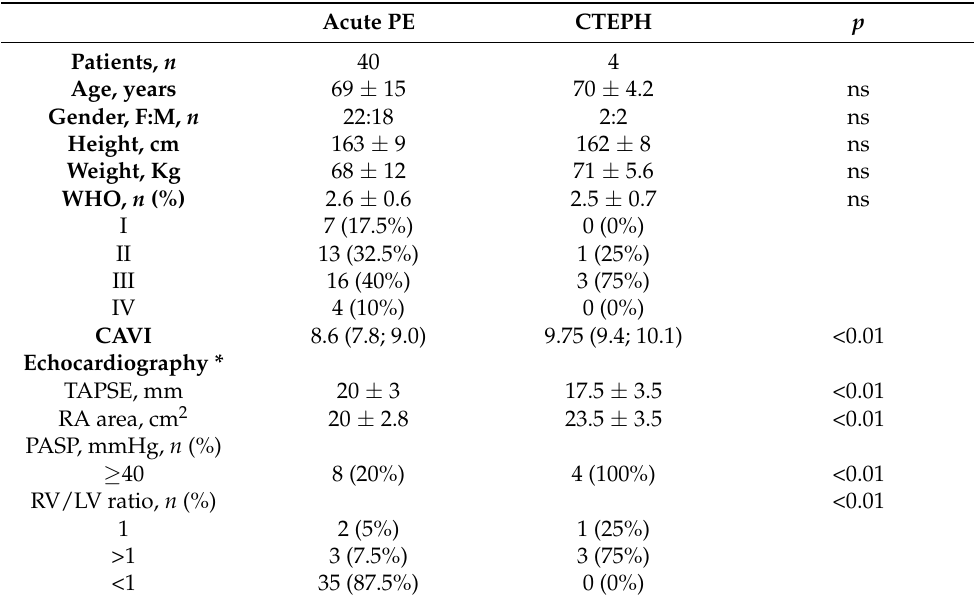
Table 2. Baseline demographic and clinical characteristics of patients with acute pulmonary embolism and